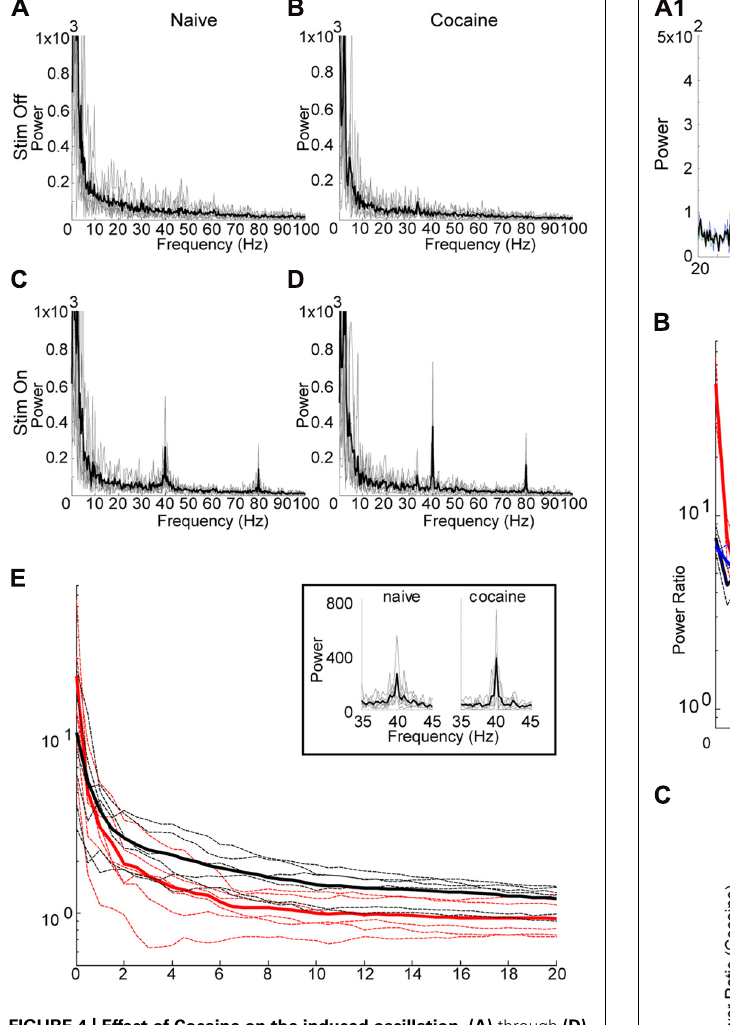
FIGURE 4 | Effect of Cocaine on the induced oscillation. (A) through (D) are power spectra (0–100 Hz) for six subjects which received 40 Hz optical stimulation for 3 s duration.Thin gray lines represent individual data, while the thicker black line represents the mean of the individual data. In a few cases significant line noise was present at precisely 60 Hz, this was excluded from the graphs by setting the power at 60 Hz to the mean of the power at 59 and 61 Hz. (A , C) are prior to i.p. cocaine injection while (B , D) are after. (A , B) represent immediately preceding the optical stimulation, while (C , D) are during stimulation. In (C , D) , there is a clearly distinguishable peak at the stimulation frequency, with a harmonic echo at 80 Hz.The shape of the peak of the induced oscillation in the cocaine treated animals (D) appears to be sharper, with increased peak power relative to the naïve condition (C) . (E) Comparison of power ratios across bandwidth frequencies from 0 to 20 Hz. Power ratio values plotted against the bandwidth “window” surrounding the 40 Hz stimulation frequency. Cocaine appears to have a sharpening effect on the induced oscillation reflected here as an increase in peak power, while decreasing the bandwidth of the induced oscillation. However, only the change in bandwidth is significant ( p = 0.008, see text). Power ratio values are shown for cocaine (red) and naïve (black) conditions.Thicker solid lines represent means, dashed lines are individual animals.The boxed inset depicts an expanded view of the induced oscillation at 40 Hz under naïve and cocaine conditions.